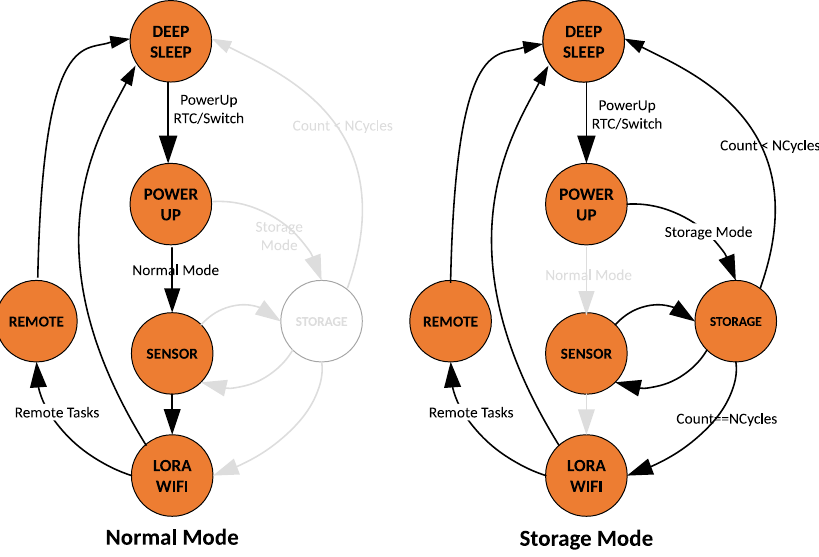
Figure 5. Operational modes and state machine of the sensor